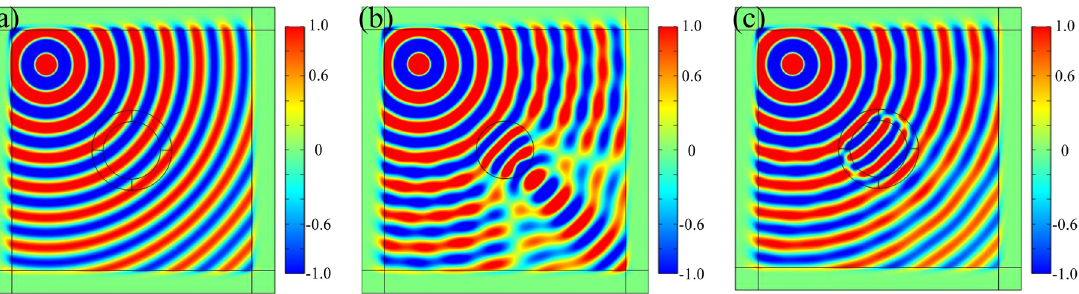
Figure 4: H z component diagram in (a) vacuum, (b) pure optical fi ber cylinder (without α -MoO 3 ) and (c) α -MoO 3 invisibility